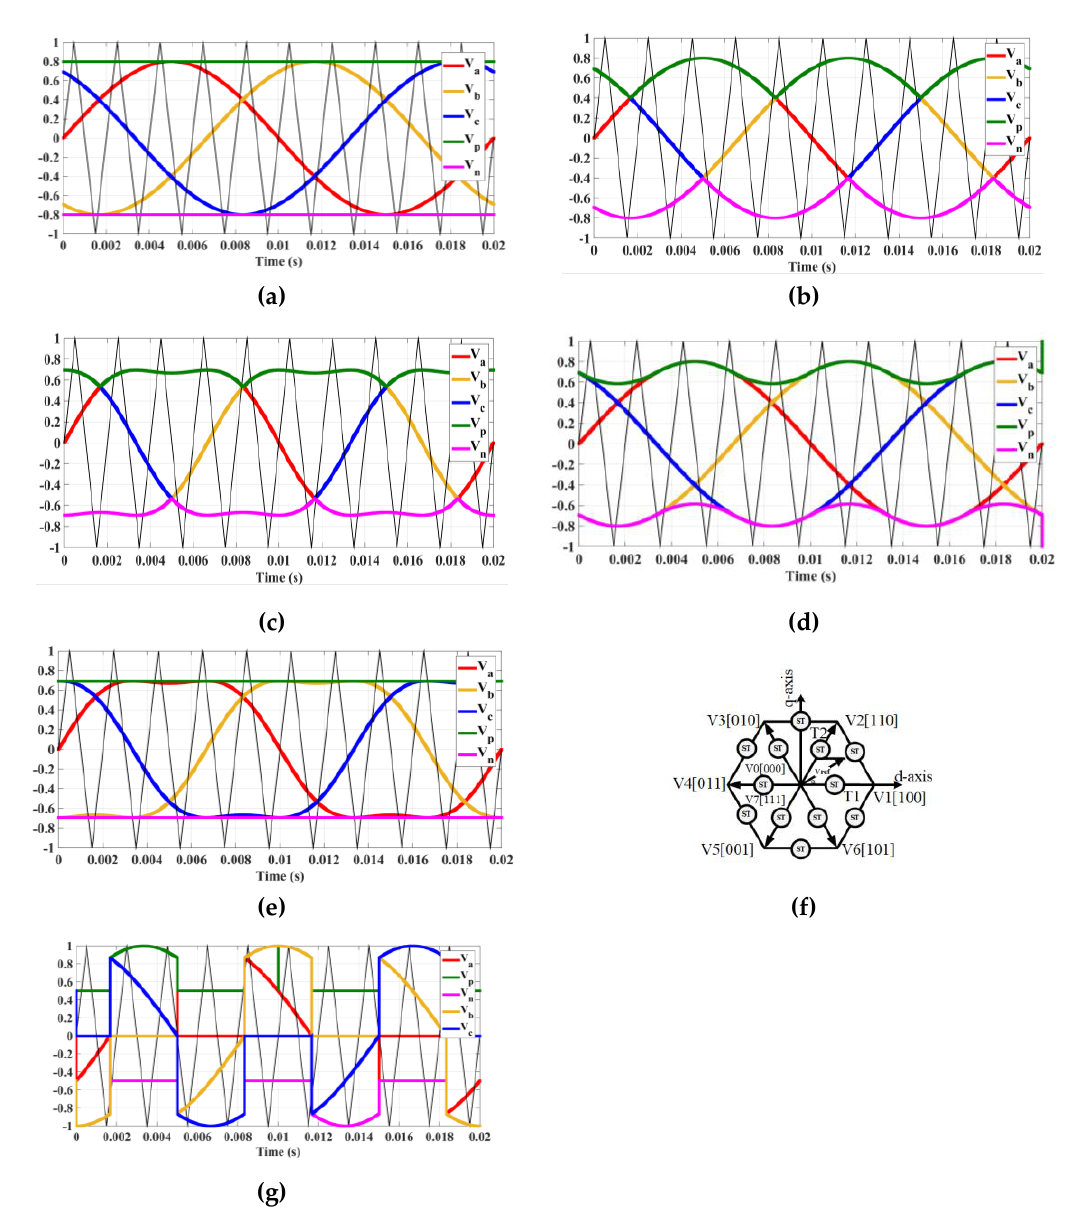
Figure 3. Three-phase ZSI PWM modulation schemes for: ( a ) SBPWM, ( b ) MBPWM, ( c ) MBPWM with the third harmonic injection, ( d ) CBPWM, ( e ) CBPWM with the third harmonic injection, ( f ) d-q representation of MSVPWM; at Modulation index (M = 0.8), fundamental frequency (f = 50 Hz), ( g ) ZSI-DCPWM at Modulation index (M = 𝟏 √𝟑⁄ ) , fundamental frequency (f = 50 Hz), DC-offset (K = 0.5).